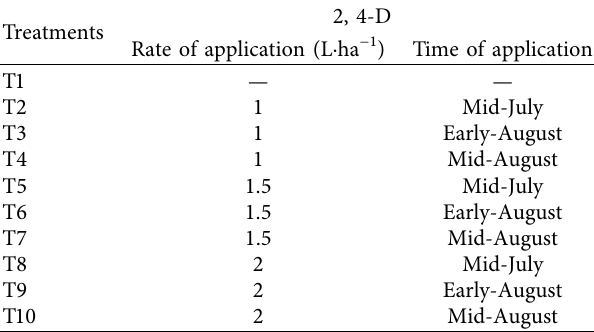
Table 3: Treatment